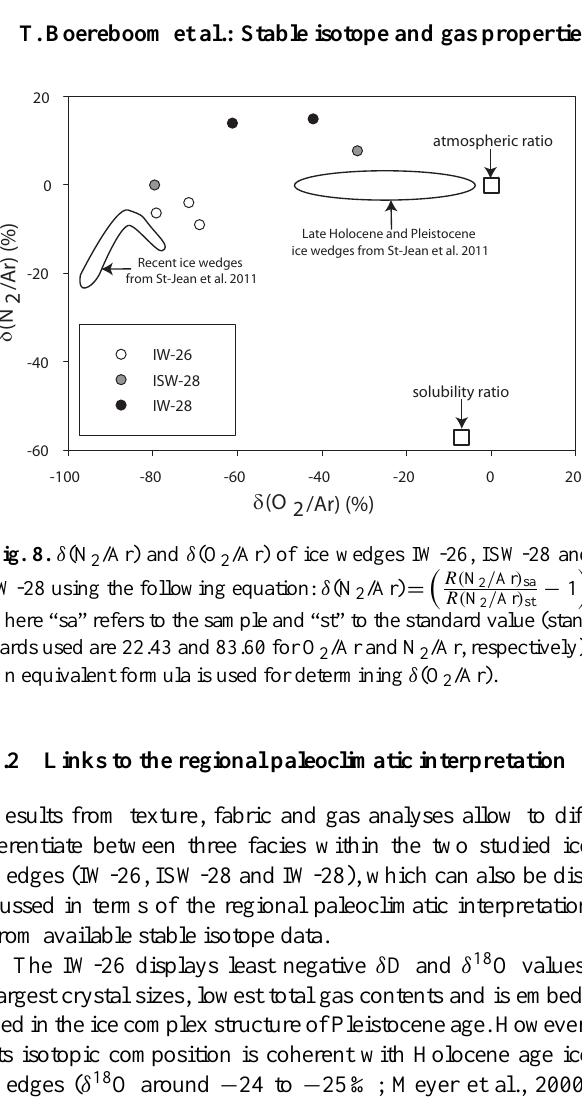
(cid:17) (cid:16) R( N − 1 2 / Ar ) sa R( N 2 / Ar ) st